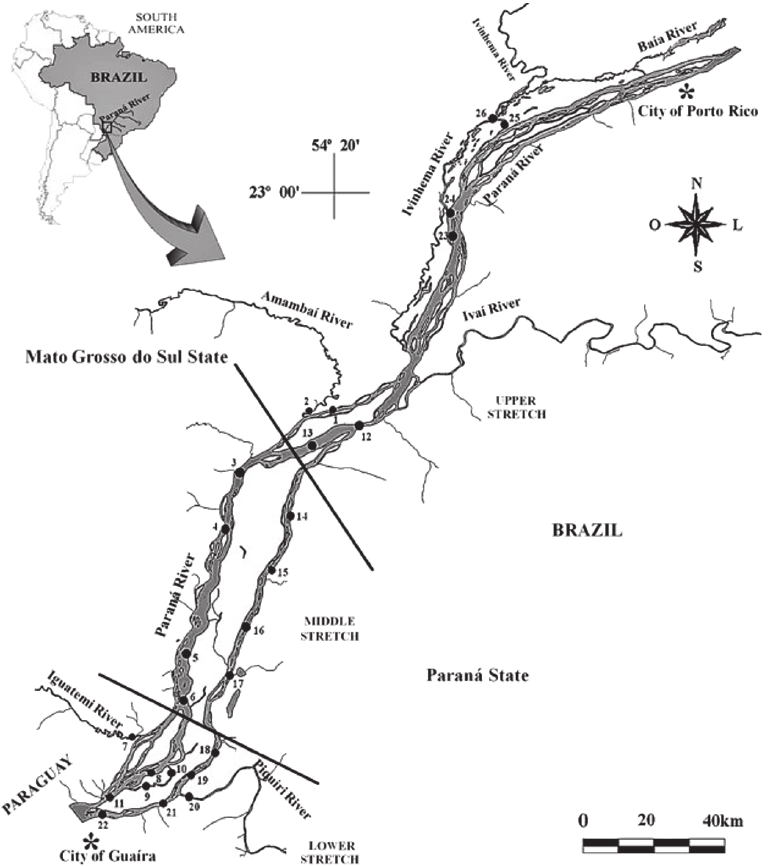
Figure 1. Location of the sampling stations (dark circles) 1: Bandeirantes Right Channel, 2: Amambai, 3: Triângulo, 4: Porto Santo Antonio,